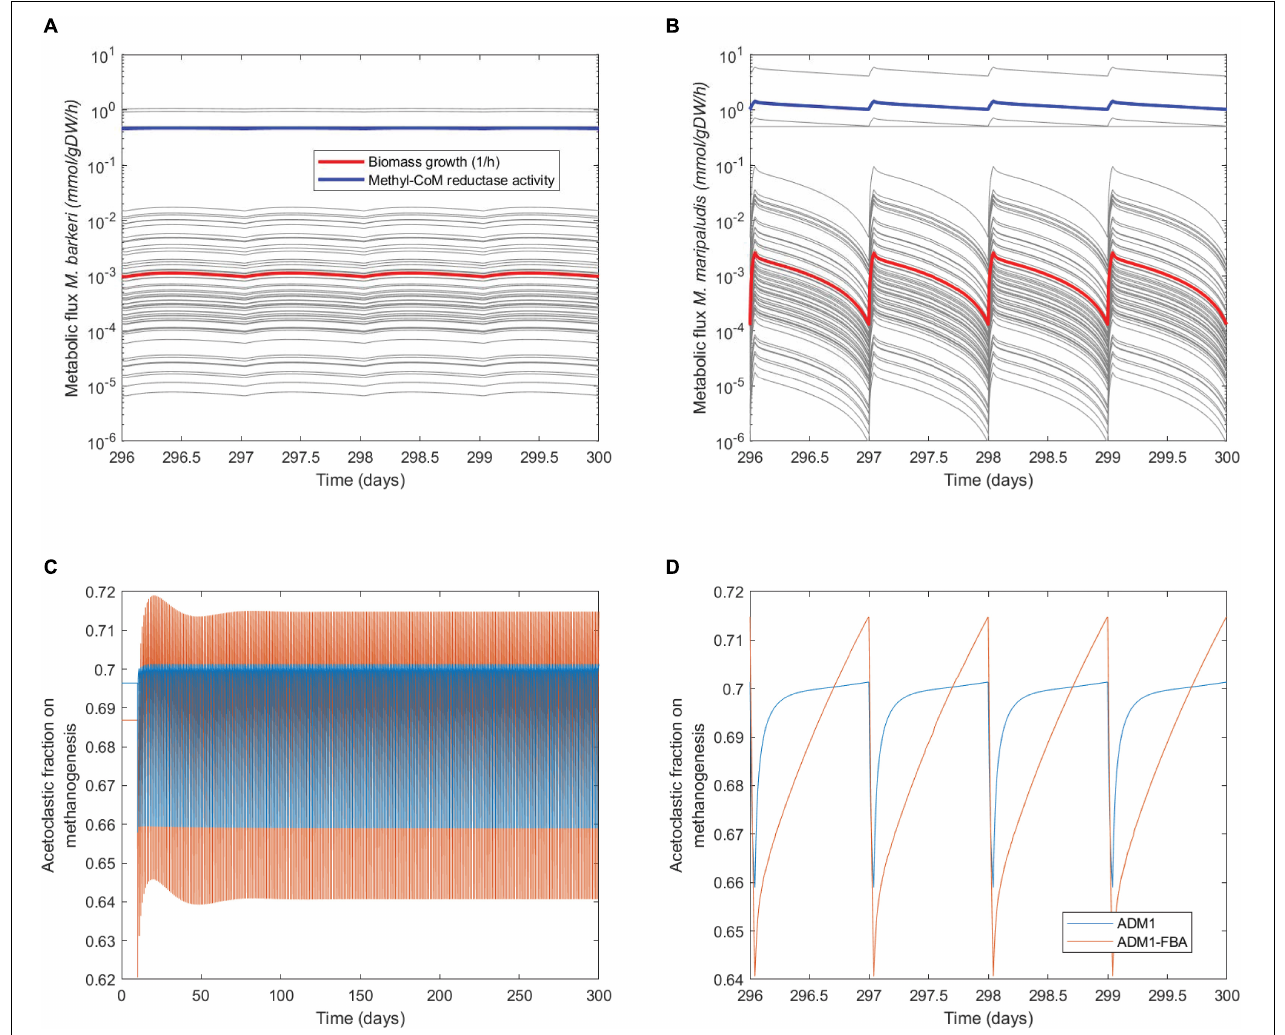
FIGURE 7 | Daily dynamics of methanogens’ growth, intracellular fluxes, and pathway contribution to methanogenesis. (A,B) Dynamics of specific growth rates and metabolic fluxes of the methanogenic FBA models, highlighting flux through methyl-coenzyme M reductase as the last step in methanogenesis. (C) Dynamics of the contribution of the acetoclastic and hydrogenotrophic pathway to methanogenesis. (D) Daily dynamics of the contribution of both pathways to